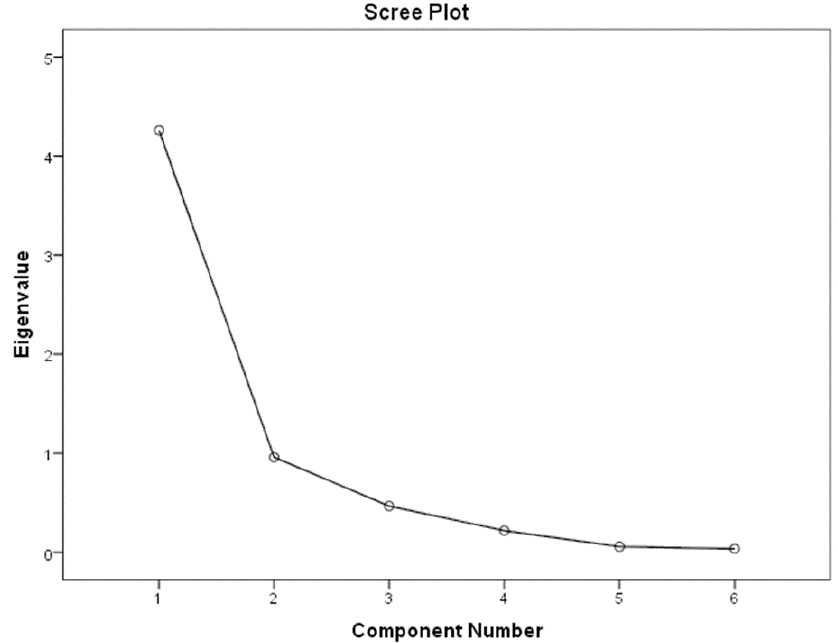
Fig 3 . Scree plot showing all components. The first principal component explains about 71% of nest size, the second and the third principal components explain about 16% and 8% respectively, accounting for 95% of the cumulative